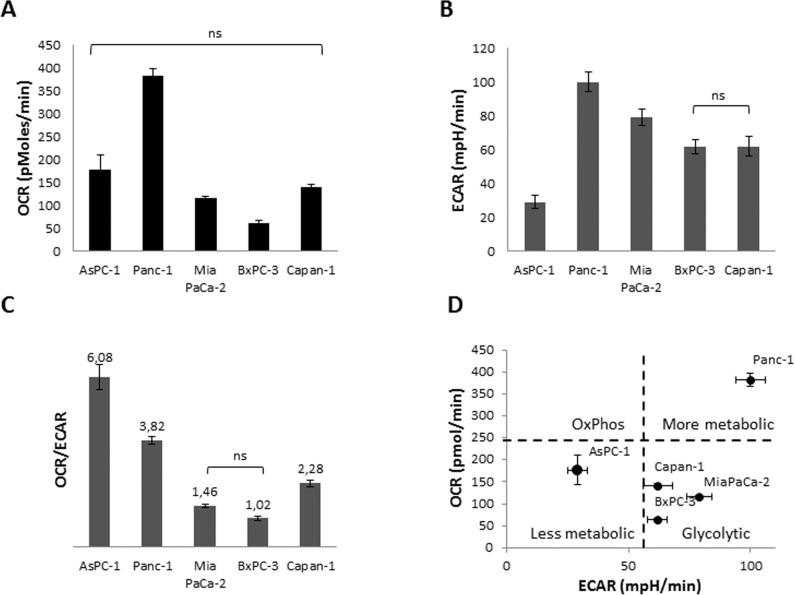
Metabolism of PDAC cell lines.(A) Measurement of OCR, (B) ECAR, (C) OCR/ECAR and (D) metabolic phenotyping were performed in Seahorse assay medium supplied with 11 mM Glucose, 2 mM Pyruvate and 2 mM Glutamine. 20 000 cells/well were seeded one day prior to the experiment. n = 12 for each cell line. Tukey’s Multiple Comparison ANOVA test was performed. All groups are significantly different unless indicated otherwise.